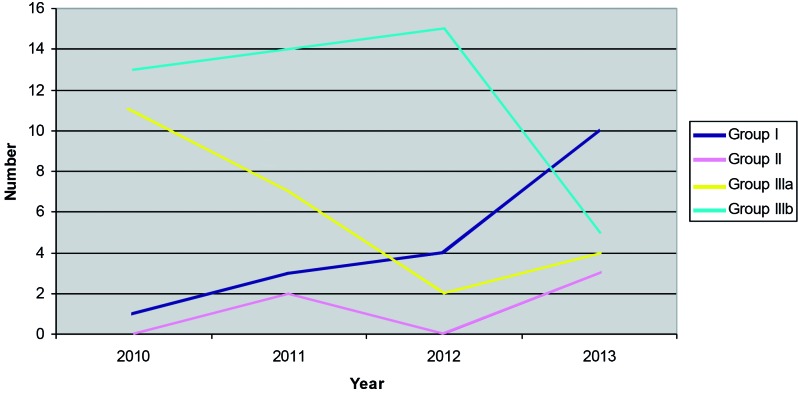
— 2013-2014: number of laparoscopies and laparotomies each year (Group I: Laparoscopy; Group II: Conversion after laparoscopy; Group IIIa:Laparotomy in low grade endometrial cancer; Group IIIb: Laparotomy in high grade endometrial cancer).